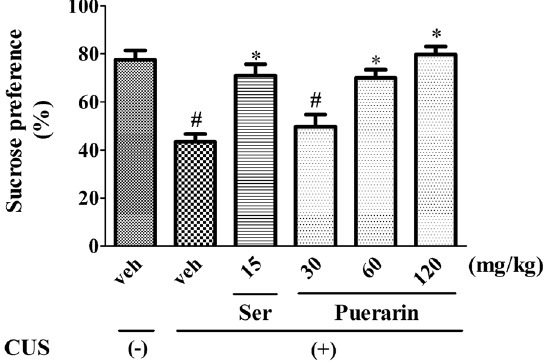
Figure 2. Puerarin attenuated the CUS-induced behavioral deficits in SPT. # p < 0.05 vs. vehicle-treated CUS ( − ) group; * p < 0.05, ** p < 0.01 vs. vehicle-treated CUS ( + ) group (n = 10 per